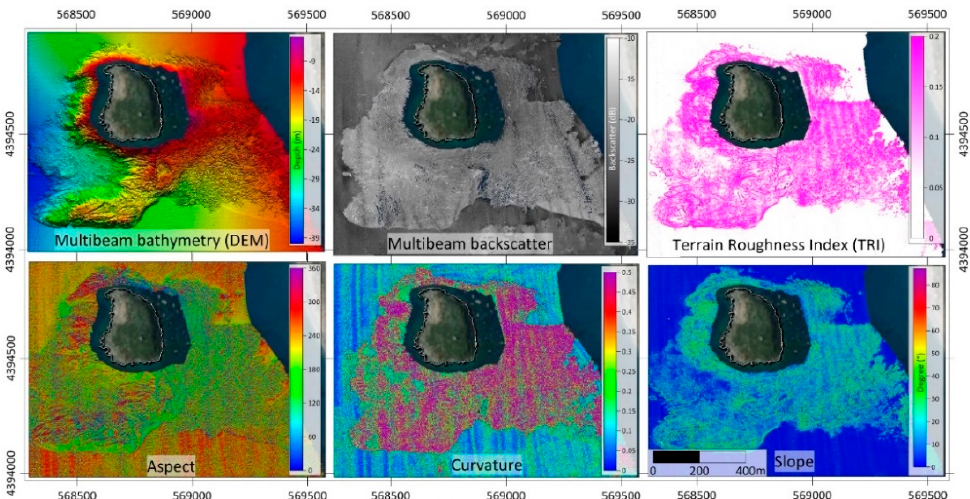
Figure 9. Bathymetry data products used to classify the seabed morphologies and acoustic facies : Multibeam Digital Elevation Model (DEM), backscatter intensity map and secondary features: Terrain Roughness Index (TRI), Aspect, Curvature and Slope obtained from postprocessing of bathymetric data.